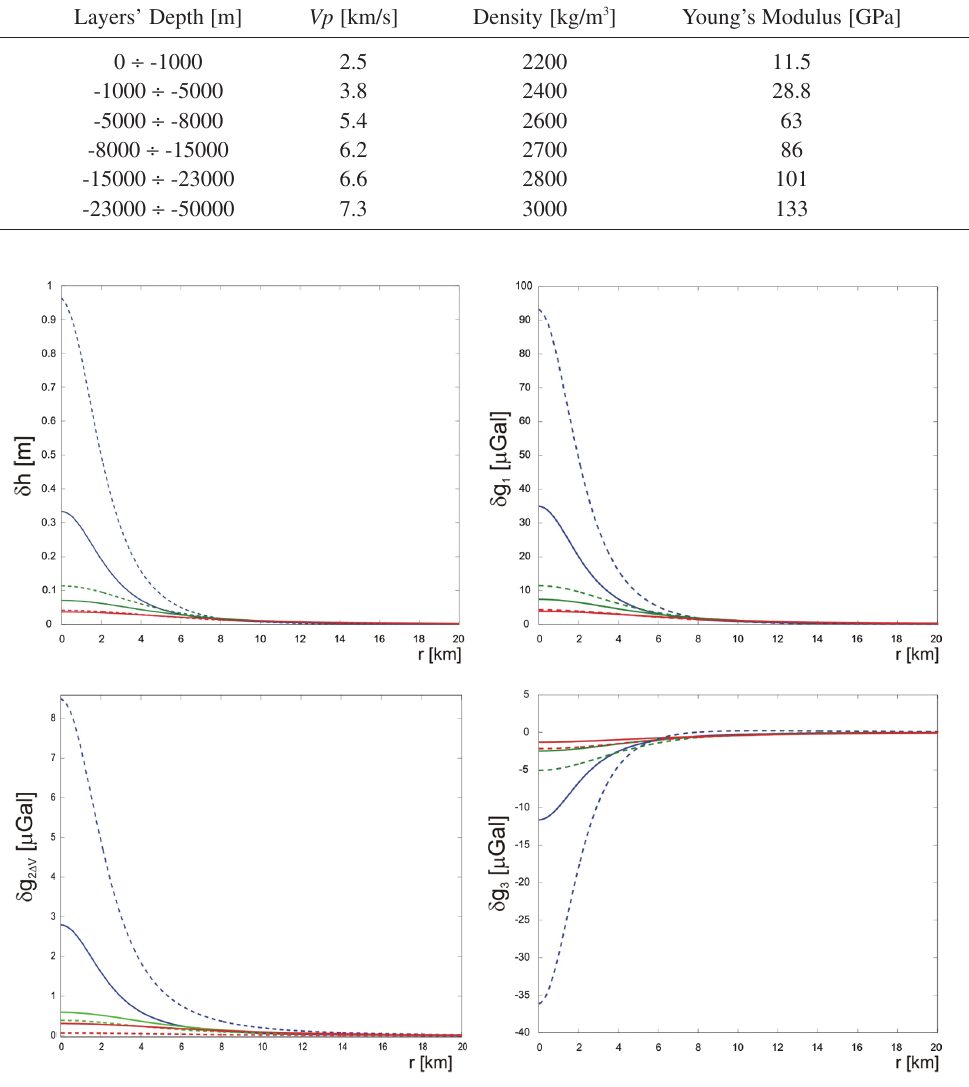
Fig. 2. Elevation and gravity changes using the heterogeneity model (dashed lines) for a source at three differ- ent depths: 3 km (blue), 6.5 km (green), 9 km (red). The analytical solutions for homogeneous medium are also shown (solid